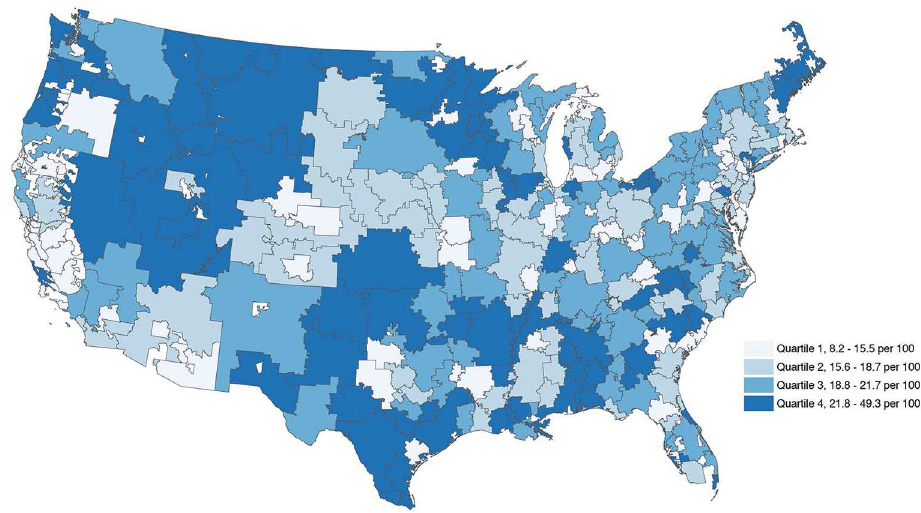
Fig 1. Variation in age, sex, race and socioeconomic status standardized ICU admission rates (per 100 hospitalization) across health referralregions the United States. Socioeconomic status was derived using a composite measureof six Census variablesrepresentingthe dimensions of wealth and income (the medianhouseholdincome; medianvalue of housingunits; and the percentage of householdsreceiving interest, dividend,or net rental income), education(the percentage of adults 25 years of age or older who had completedhigh school and the percentage of adults 25 years of age or older who had completedcollege),and occupation(the percentage of employedpersons16 years of age or older in executive, managerial,or professional specialty occupations). Fig 1. An interactive version of Fig 1 is available at https://s3-us-west-2.amazonaws.com/ colinrcooke/visualization/incidencemap.html